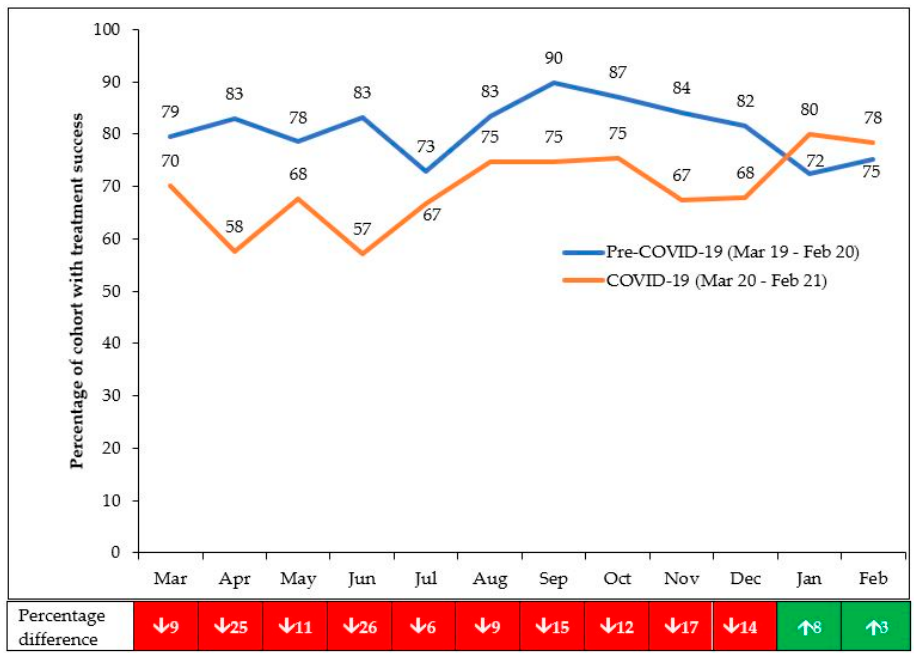
Figure 3. Treatment success amongst patients enrolled each month in 10 health facilities in Harare, Zimbabwe, during pre-COVID-19 and COVID-19 periods. Enrollment occurred eight months prior to the month of reporting (to allow for 6 months treatment and 2 months of follow-up and record the final outcome); ↑ = increase; ↓ = decrease. The interventions applied from July onwards included: medication refills given for longer periods and synchronized for TB and ART medications; attempts to reduce the outcome “not evaluated”.